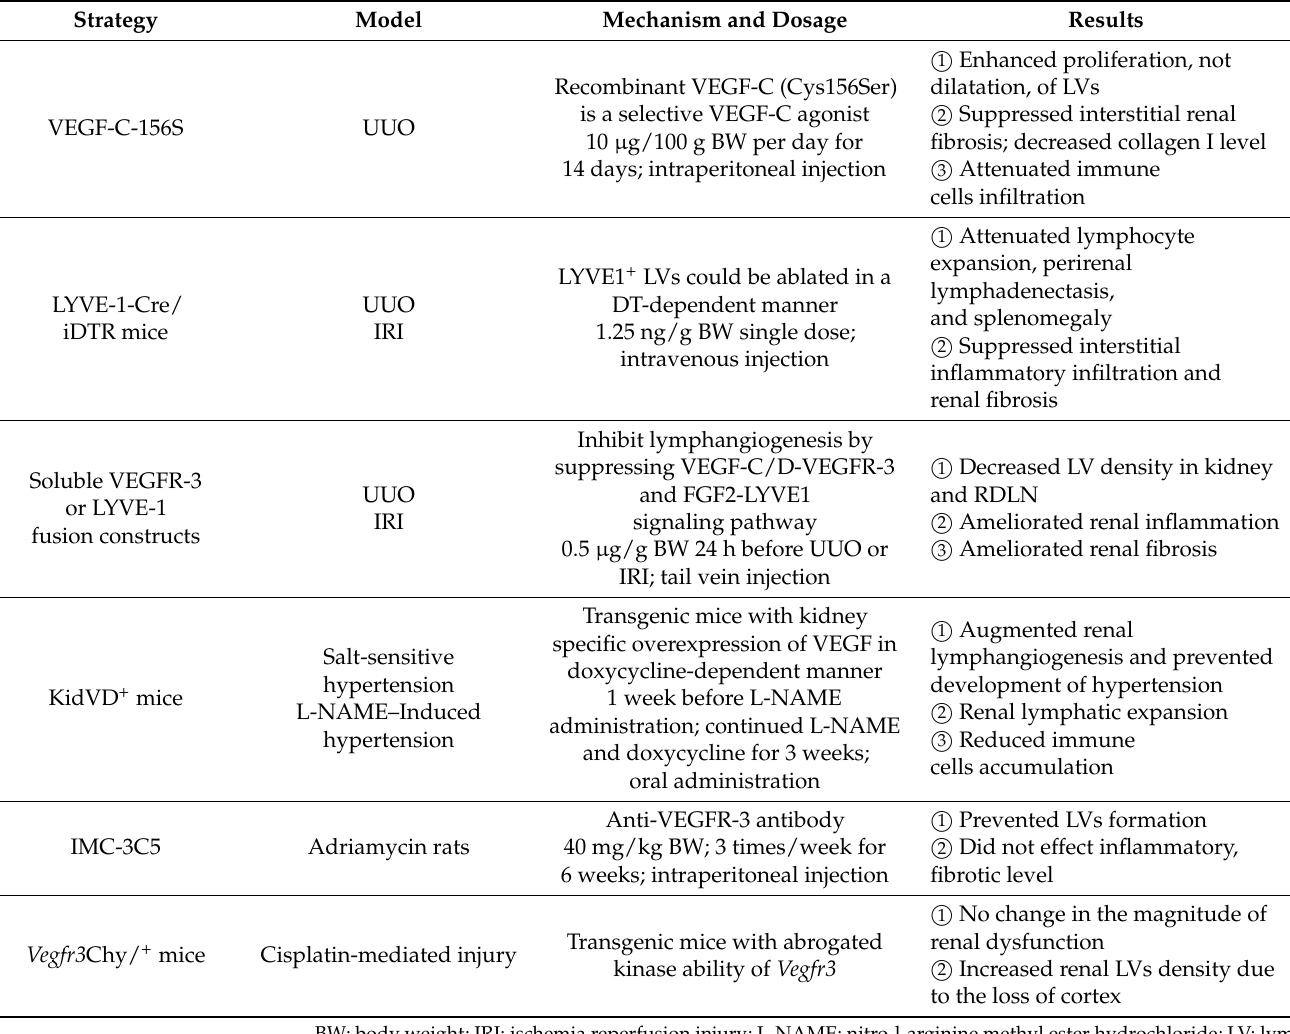
Table 2. Lymphatic-related treatment of chronic kidney